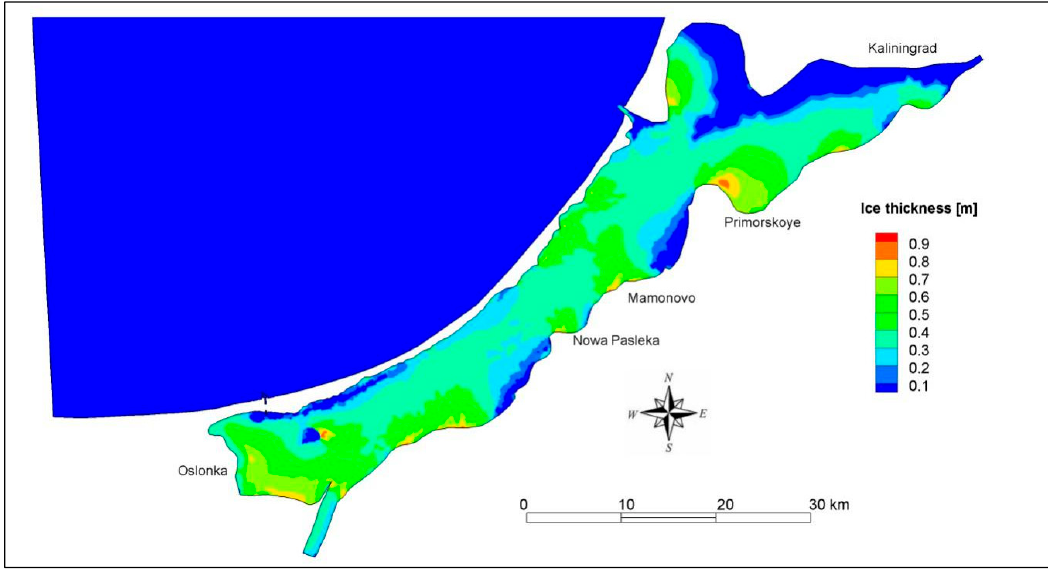
Figure 9. Simulation results of ice thickness for wind blowing from a North-East direction.